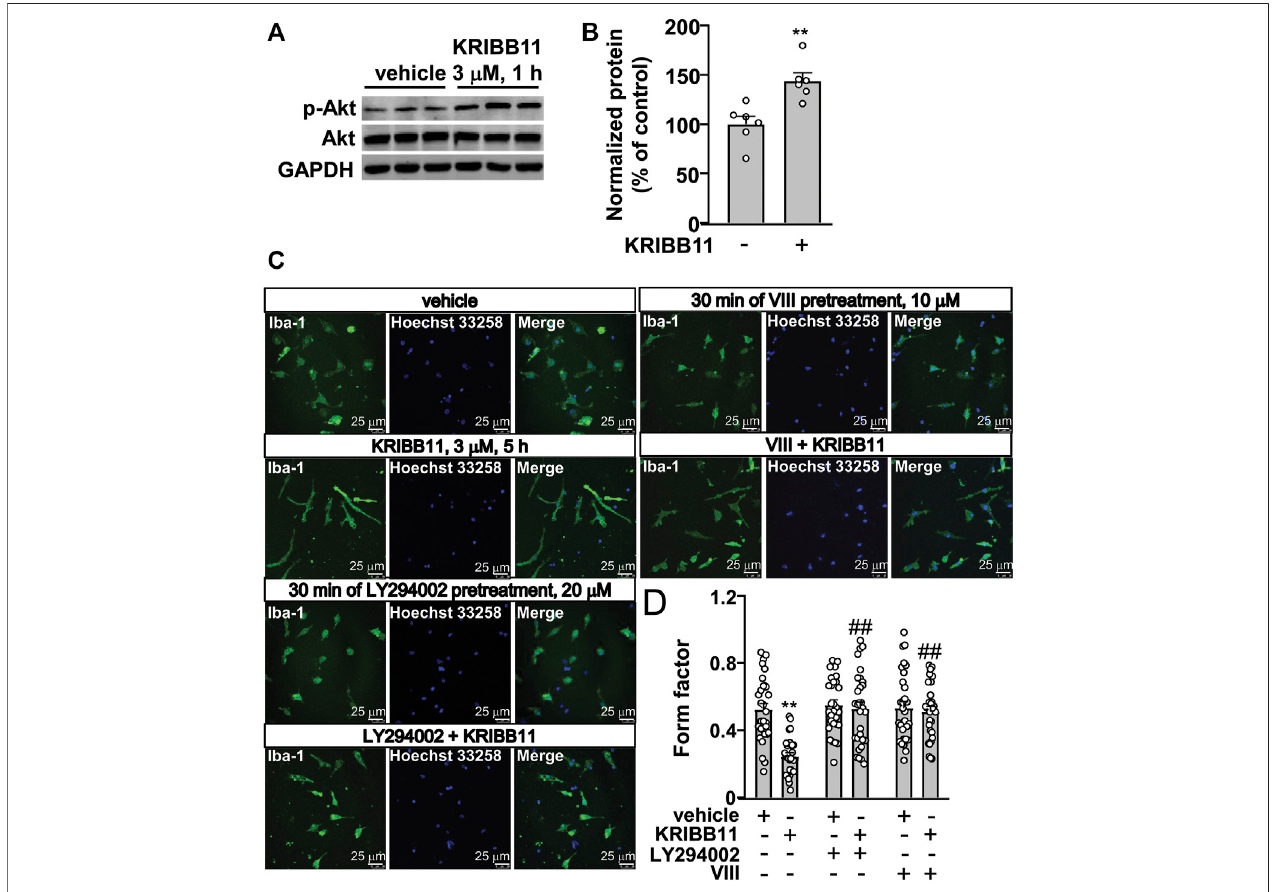
FIGURE6| Aktactivationmediatesthepro-elongationeffectofKRIBB11onprimarycultured microglialprocess. (A,B) Representativeimages (A) andquantitative analysis (B) showed that KRIBB11 incubation (3 μ M, 30 min) induced a signi fi cant increase in the phosphorylation levels of Akt in primary cultured microglia ( n = 6, ** p < 0.01vs.vehicle). (C,D) Representativeimages (C) andquantitativeanalysis (D) showedthatinhibitionofAktactivitybyLY294002(20 μ M,30 min)orVIII(10 μ M,30 min) pre-incubation prevented the pro-elongation effect of KRIBB11 (3 μ M, 5 h) on primary cultured microglial process (** p < 0.01 vs. vehicle, ## p < 0.01 vs. vehicle + KRIBB11). For cell shape investigation, 30 cells per condition were analyzed in three independent experiments. Scale bars: 25 μ m. Data are shown as mean ±